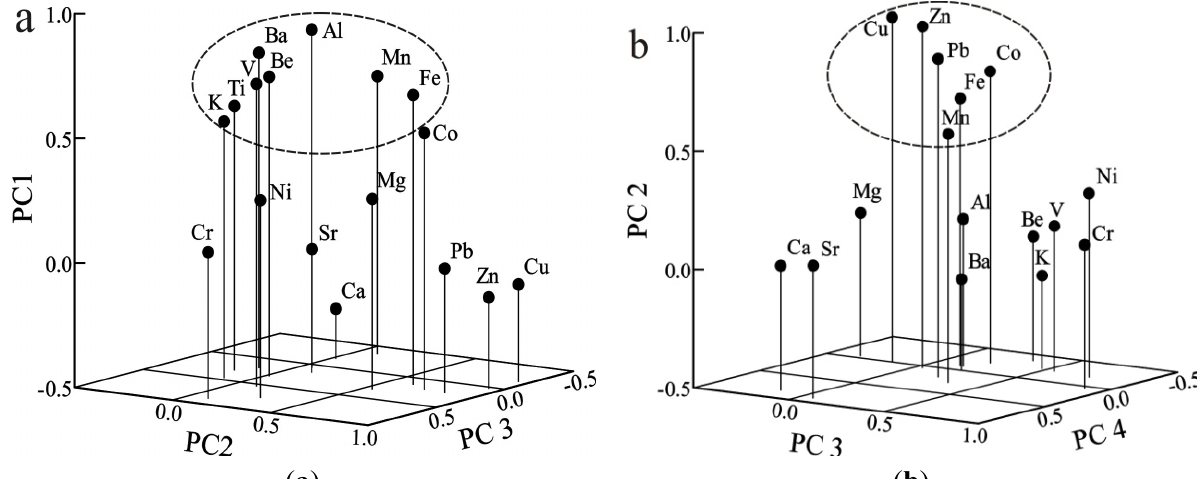
Figure 3. Loadings of the rotated eigenvectors, vertical axis are the relevant component: PC1, PC2, PC3 and